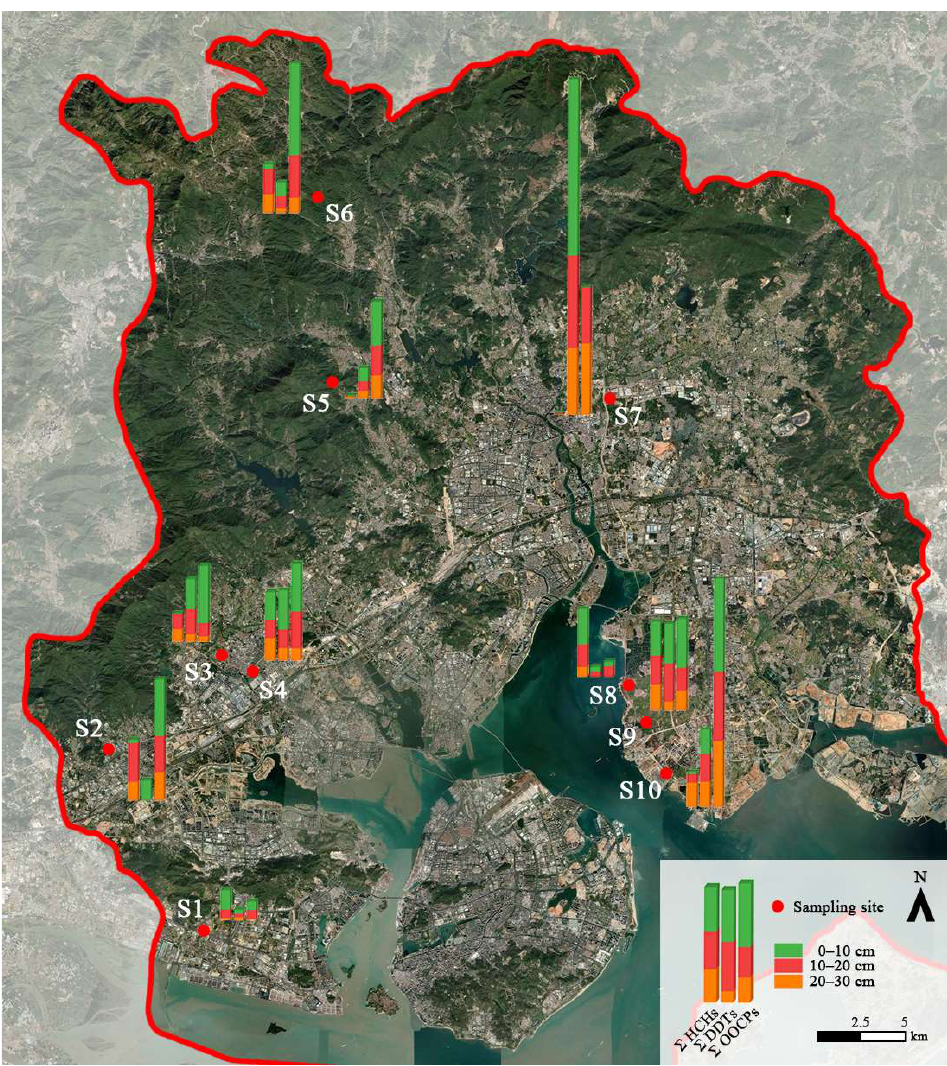
Figure 2. The spatial distribution of OCPs in agricultural soil of Xiamen.